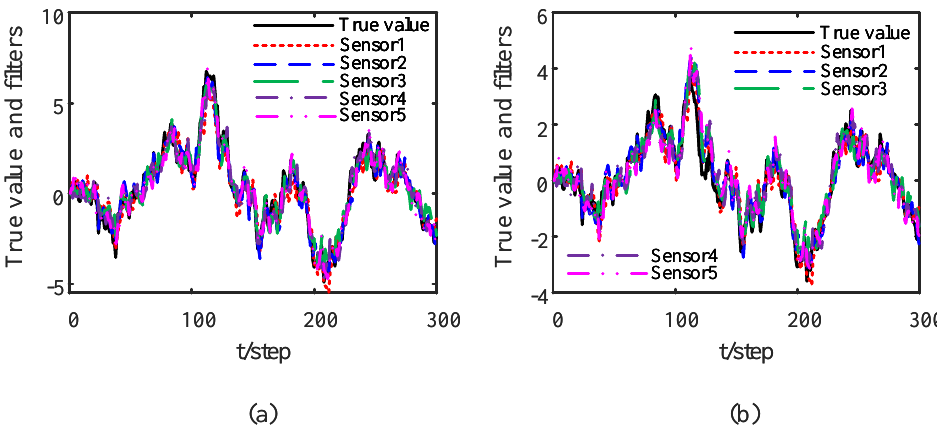
Figure 2. Tracking effects of DOFCDs of five sensor nodes: ( a ) tracking for the position; ( b ) tracking for the velocity (authors’ own processing).